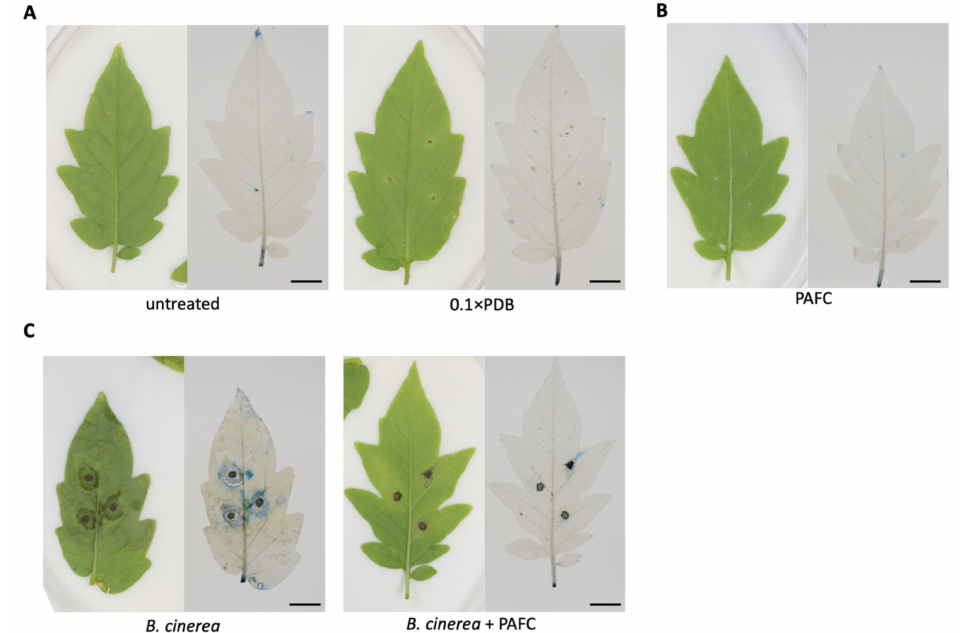
Figure 9. PAFC tolerance of tomato plant leaves and protective effect of PAFC against B. cinerea infection. The phenotype of leaves is shown in the left panels and damage evaluation with Evan’s blue staining in the right panels. ( A ) Leaves were either left untreated or treated with 10 µ L of 0.1 × PDB (negative controls). ( B ) For toxicity testing, leaves were treated with 10 µ L of PAFC (1 mg mL − 1 ). ( C ) Plant protection efficacy was evaluated with leaves infected with 10 µ L of B. cinerea conidia (10 7 conidia mL − 1 ) (infection control) and conidia mixed with PAFC (1 mg mL − 1 ). Plants were then further incubated for four days at 23 ◦ C under photoperiodic day/night simulation (12/12 h with or without illumination at 1200 lux) and then harvested for staining. Scale bar, 10